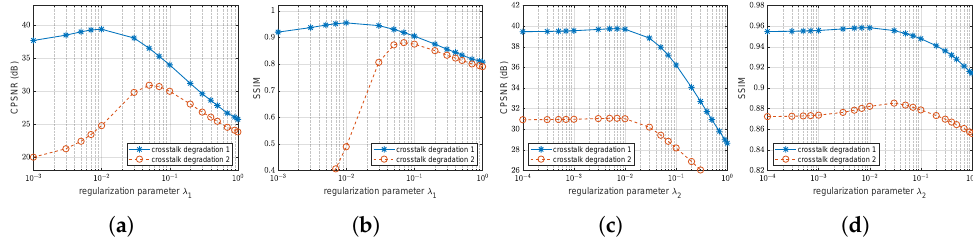
Figure 11. Objective performance comparison for test image Parrot according to regularization parameters λ 1 and λ 2 : ( a ) CPSNR values versus values of λ 1 ; ( b ) SSIM values versus values of λ 1 ; ( c ) CPSNR values versus values of λ 2 ; and ( d ) SSIM values versus values of λ 2